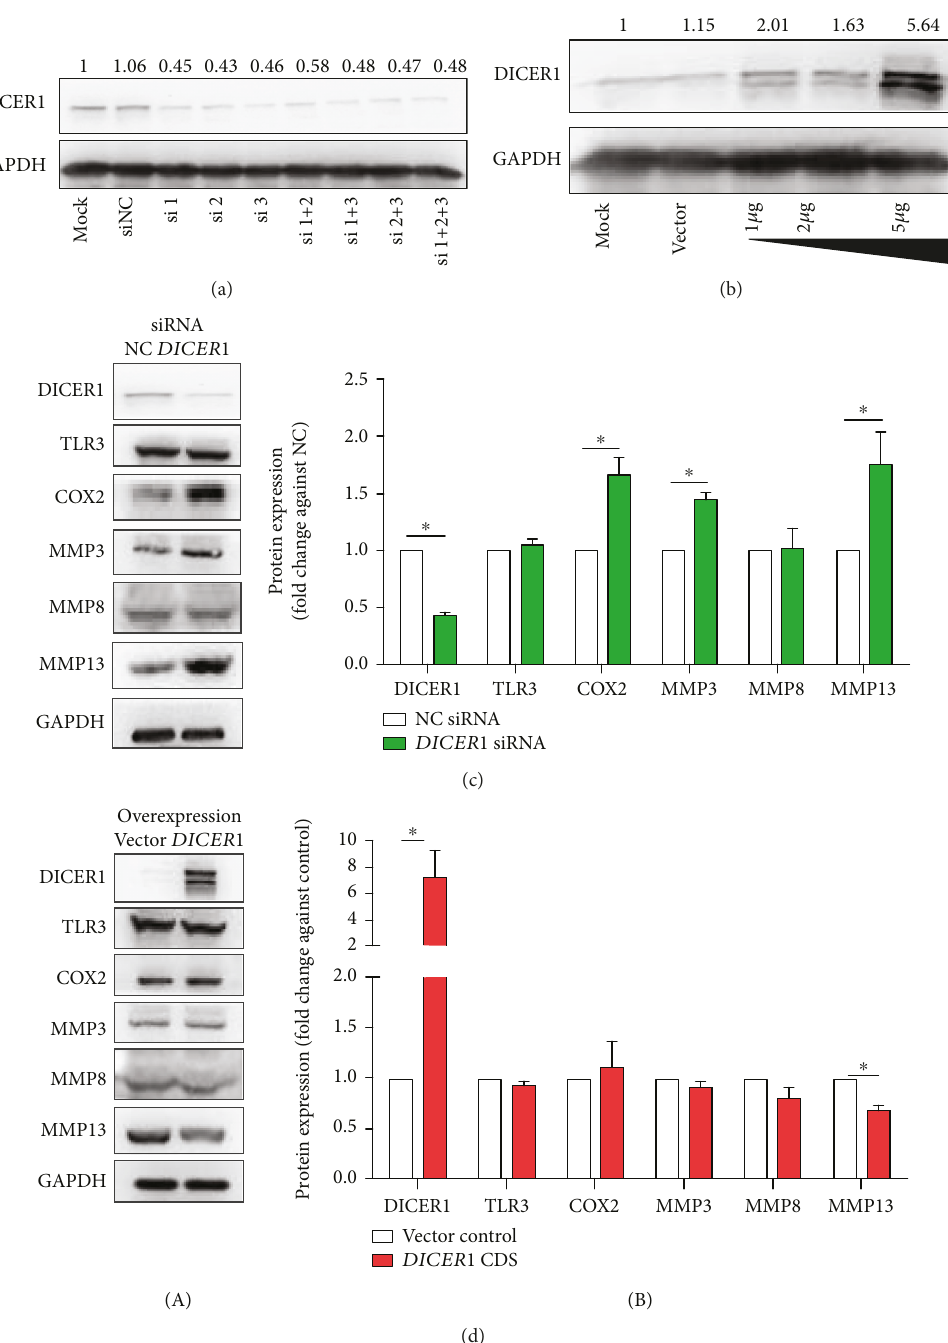
Figure 1: Altered intracellular protein expression caused by gain or loss of DICER1 function for 48 h in human synoviocytes SW982. (a) Representative Western blotting image of DICER1 expression after transfected with 10 nM DICER1 siRNAs 1, 2, and 3 or multiple combinations. (b) Representative Western blotting image of DICER1 expression after transfected with 1, 2, and 5 μ g overexpression vector per well in 6-well plates. (c) Western blotting results of DICER1, TLR3, COX2, MMP3, MMP8, MMP13, and GAPDH protein expression after DICER1 RNAi. (d) Western blotting results of DICER1, TLR3, COX2, MMP3, MMP8, MMP13, and GAPDH protein expression after DICER1 overexpression. (A) Representative images; (B) quantitative results. Bar: mean ± SEM from three independent cell experiments, ∗ P < 0 05 using the Mann-Whitney